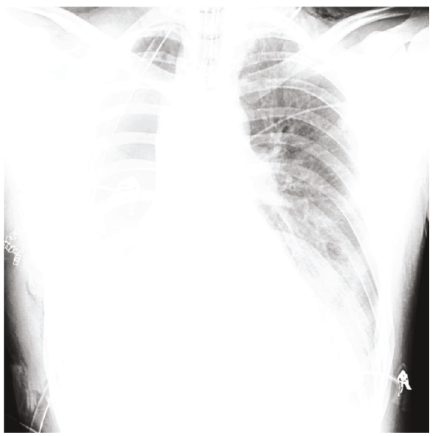
Figure 3: Suggested management approach for post- pneumonectomy patient with acute respiratory distress